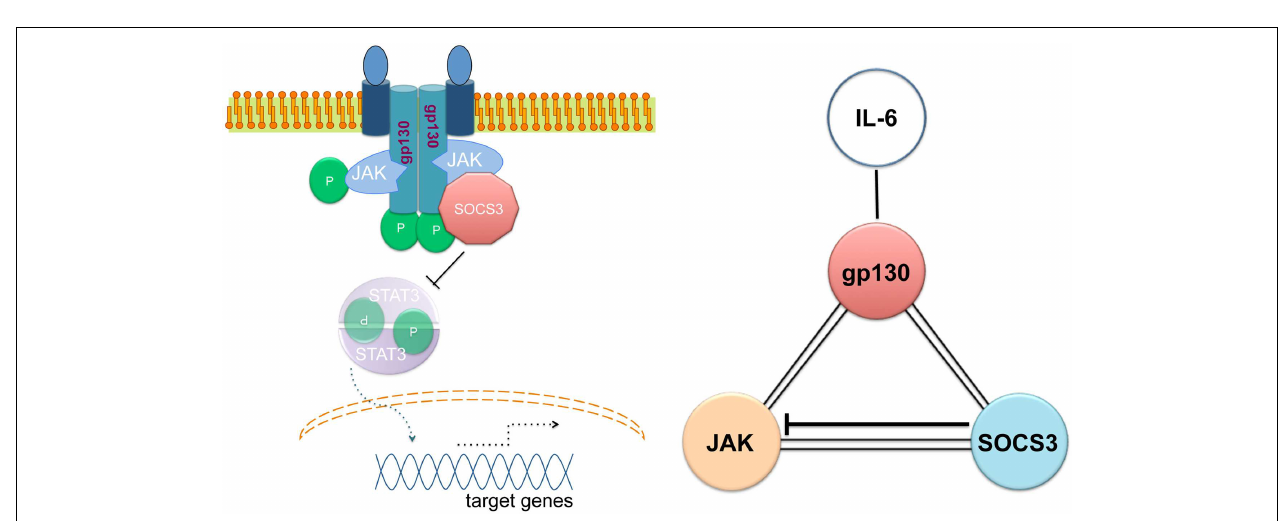
FIGURE 1 | Simultaneous binding of SOCS3 to JAK and the gp130 cytokine receptor . Adapted from Ref.